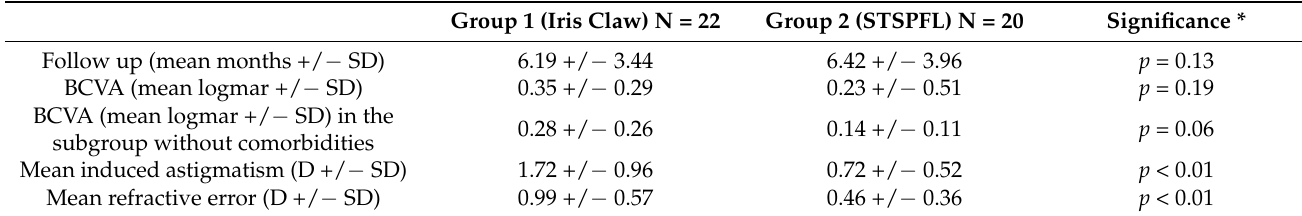
Table 2. Comparison of main post-operative outcomes between two groups.